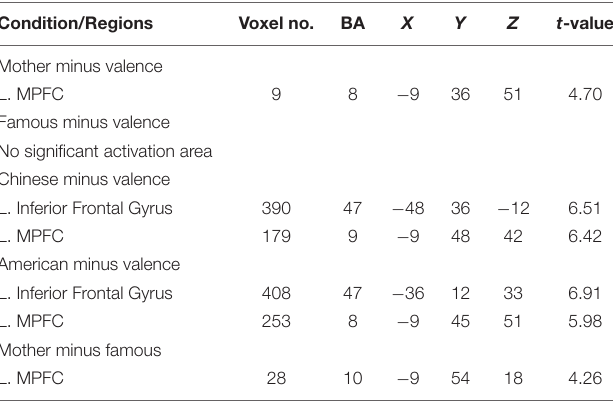
TABLE 1 | Regions of significant increased activation in comparison between mother, famous, China and America with valence judgments, main effect of self and interaction of self × information type (corrected, p < 0.05).